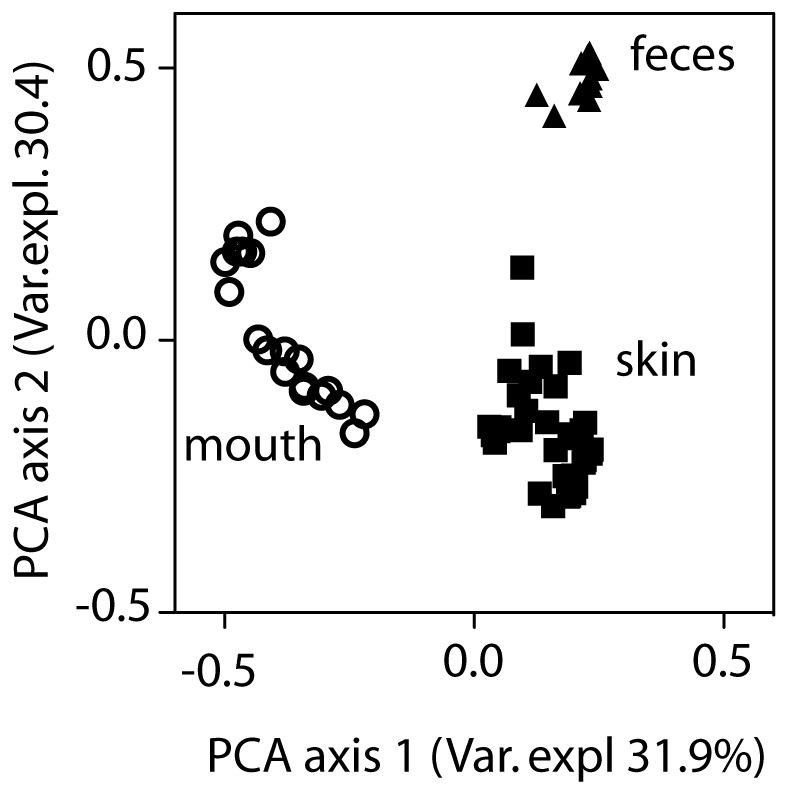
The microbiomes of skin, mouth and colon are distict.Principle coordinates analysis of unweighted UniFrac distances among microbiomes from feces, skin and mouth isolated from all mice examined is shown. All 3 groups differed significantly from each other by ANOSIM (p<0.001).